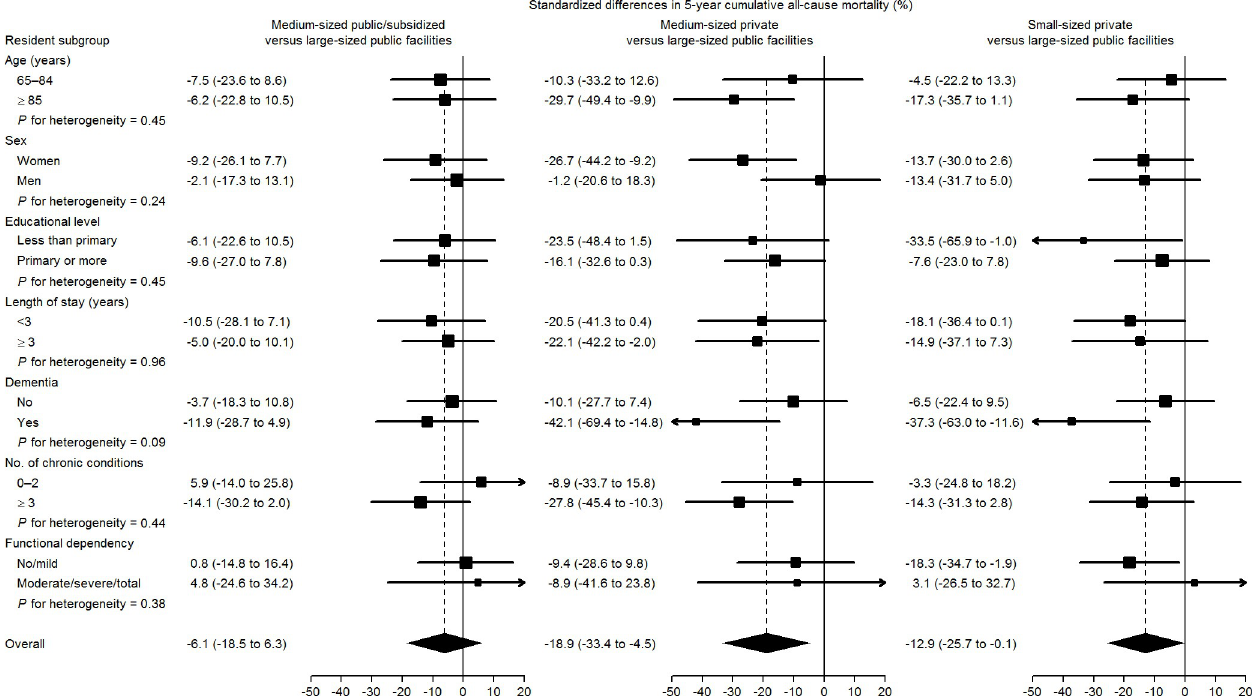
Fig 2. Standardized differences in 5-year cumulative all-cause mortality, (reference: Large-sized public facilities) in pre-specified subgroups. Subgroup- specific risk differences (squares with area inversely proportional to the variance) and their 95% CIs (horizontal lines) were obtained from spline-based survival models weighted by combined inverse probability weights and stratified by type of facility and resident subgroup. Subgroup-specific weights were used to standardize cumulative mortality in each type of facility and resident subgroup to the weighted distribution of baseline confounders in the entire resident subgroup, including age (65–74, 75–79, 80–84, 85–89, or � 90 years), sex (female or male), educational level (less than primary or primary or more), length of stay in the nursing home ( < 3 or � 3 years), dementia (yes or no), number of chronic conditions other than dementia (0–2 or � 3), and functional dependency (no/mild, moderate, or